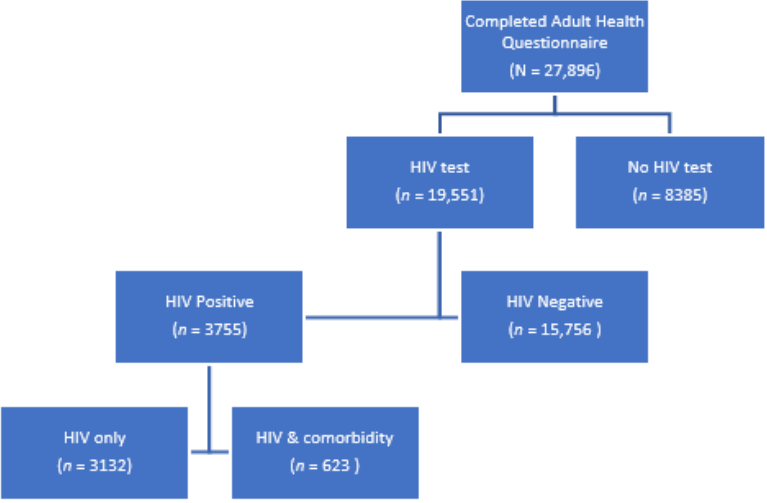
Figure 1. HIV testing in the SABSSM 2017 sample.